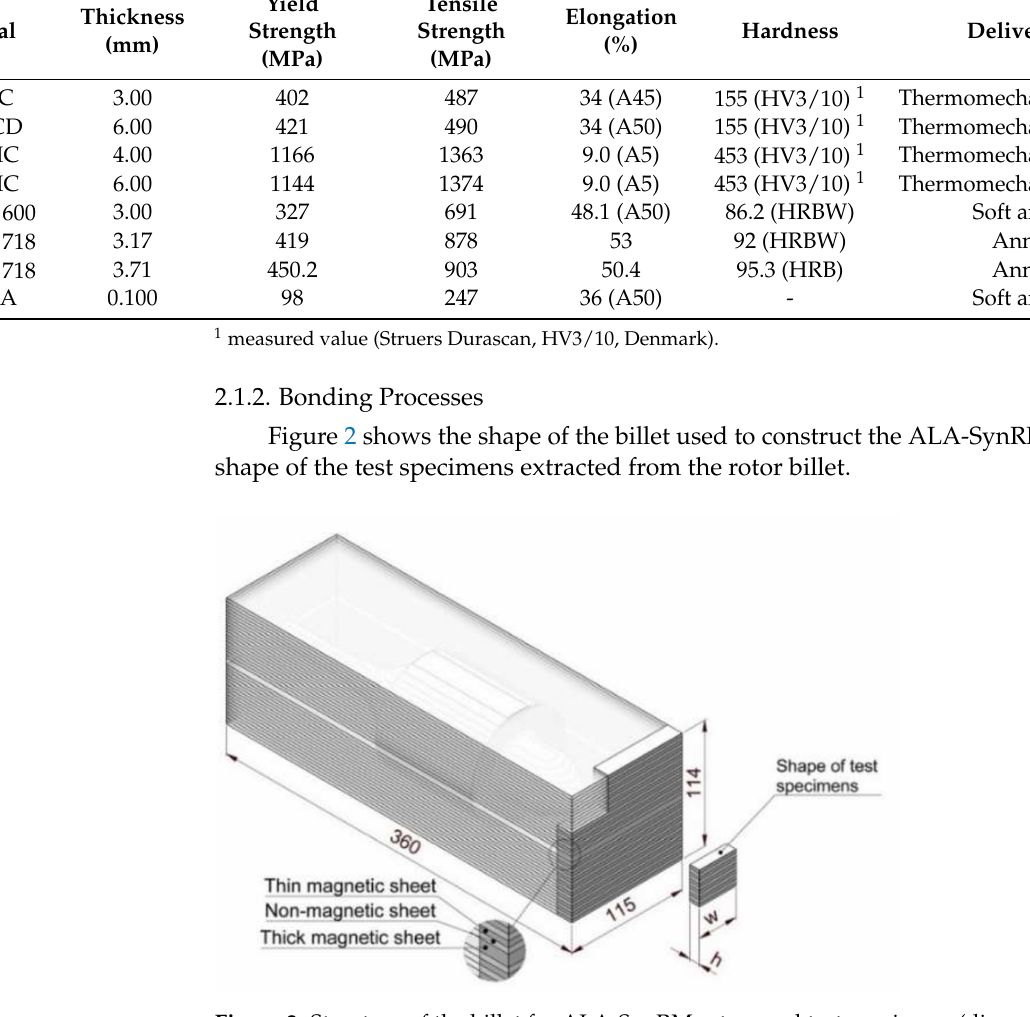
Figure 2. Structure of the billet for ALA-SynRM rotors and test specimens (dimensions in mm, not to